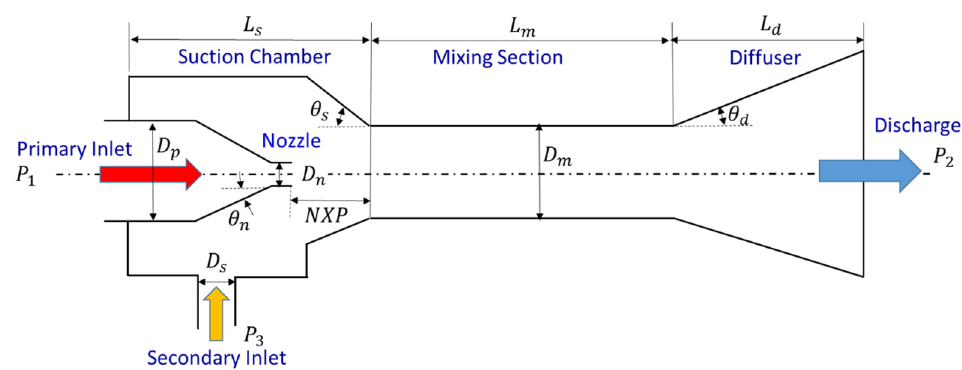
Figure 4. Schematic diagram of an ejector.